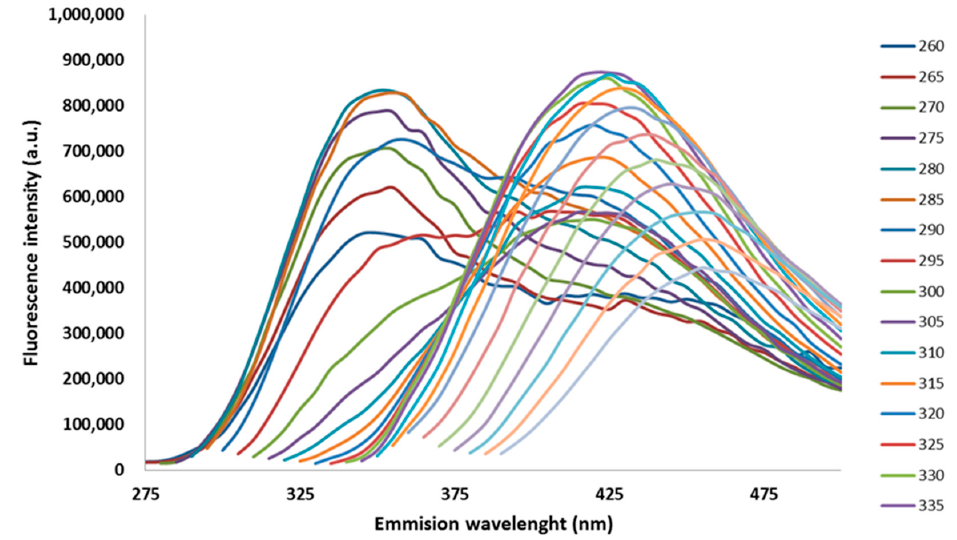
Figure 1. The excitation–emission matrix (EEM) for the honey sample obtained from the beehive with 0.056 V. destructor infestation.